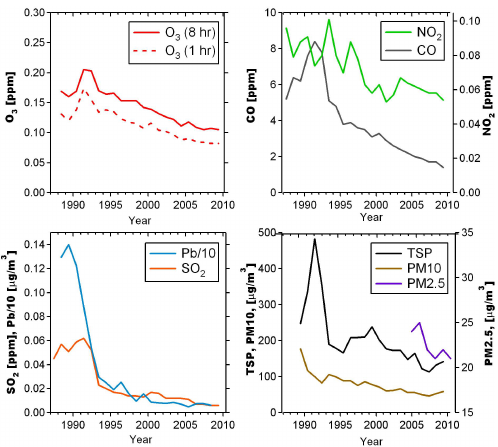
Fig. 3. MILAGRO Campaign: Geographic Coverage. Measure- ments were performed in the MCMA (see Fig. 4). The size of the circle (MAX-Mex, MIRAGE-Mex and INTEX-B) indicates the ge- ographic coverage of the aircraft